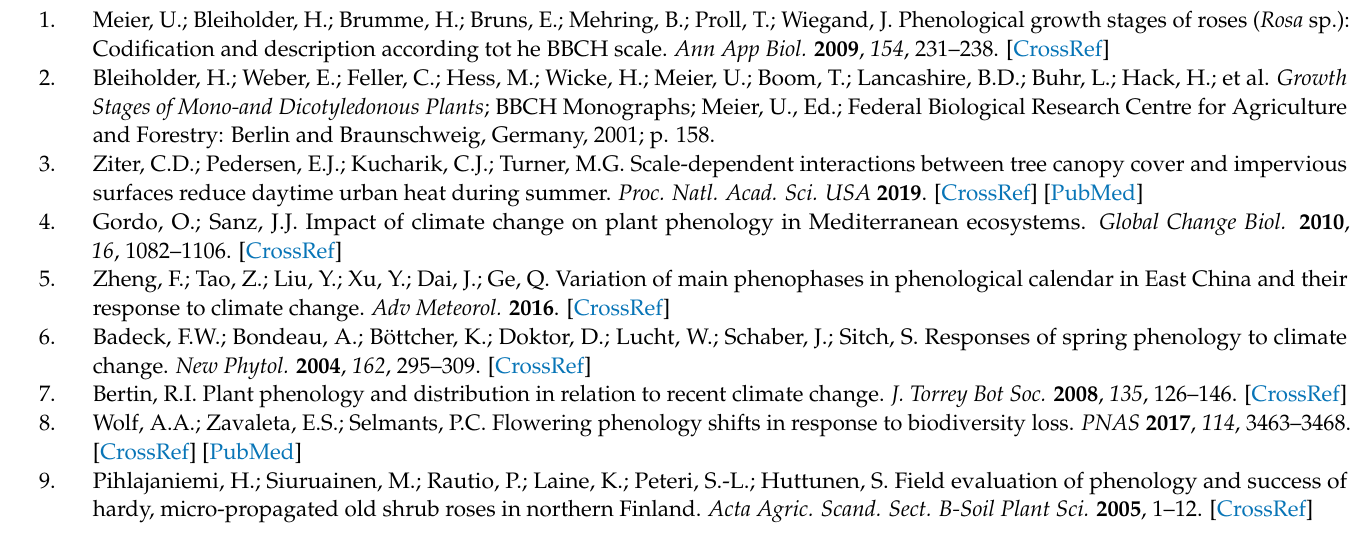
Figure S2: The total monthly precipitation (mm) and month mean in the years 2000–2016,